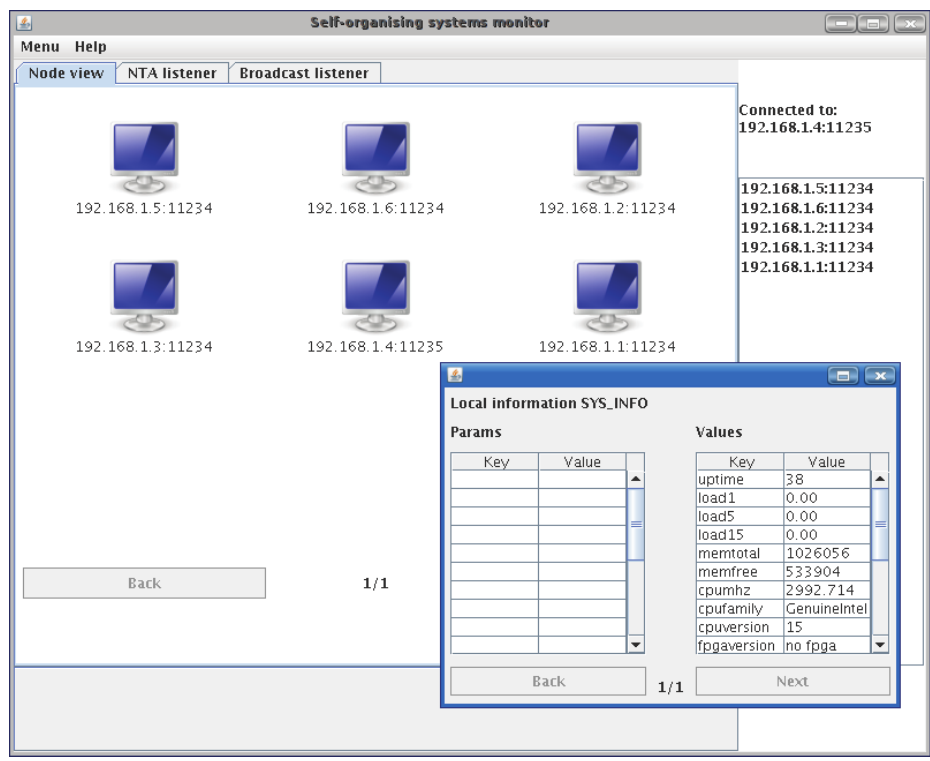
Figure 5: Communication between monitor daemons using the NTN interface and with applications using the NTA